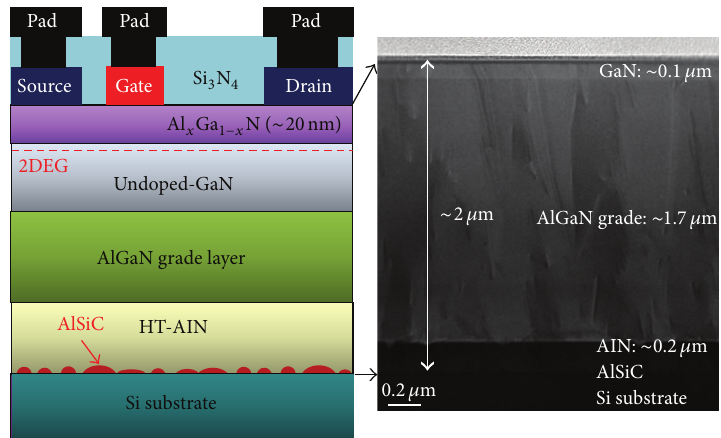
Figure 1: A schematic cross-sectional view and TEM image of the fabricated MESFET layer